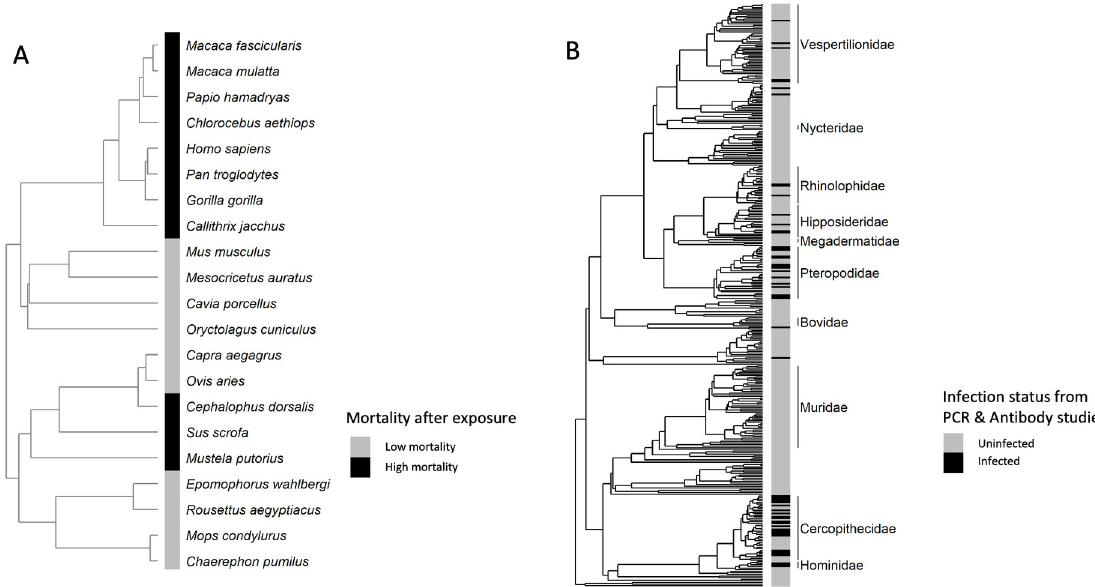
Fig 1. Mortality of species after exposure to Ebolavirus plotted on maximum clade credibility tree (A) and infection status of species determined from antibody and PCR tests plotted on maximum clade credibility tree (B).